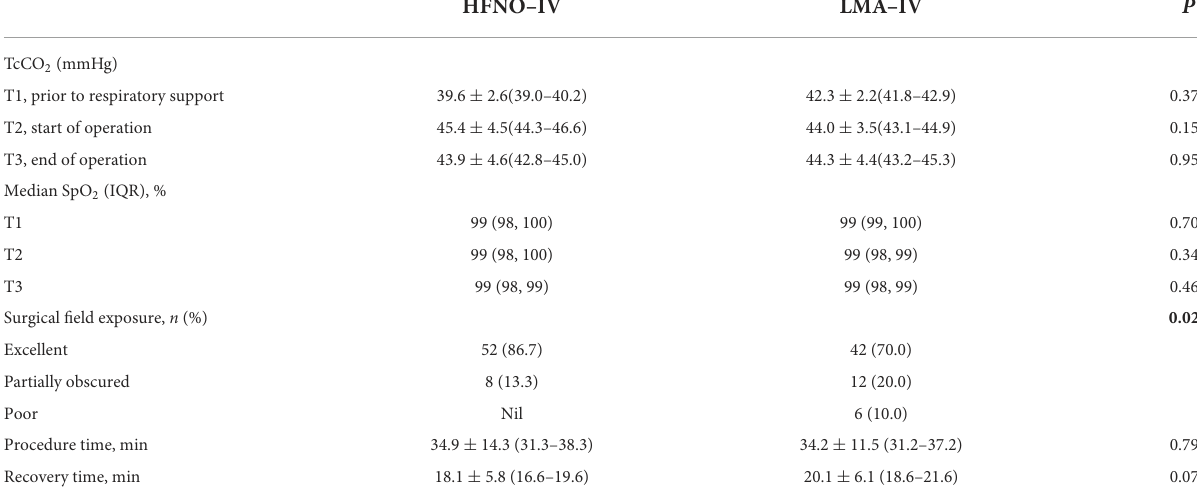
TABLE 2 TcCO 2 , SpO 2 , surgical field exposure, time of the procedure, and recovery in two groups.